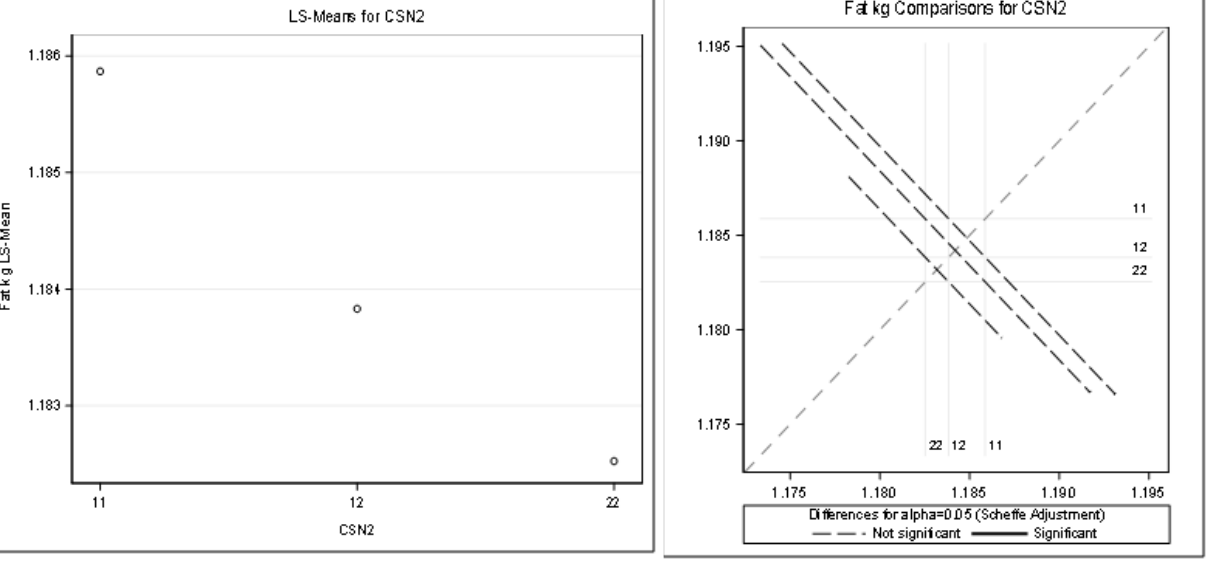
Figure 5. Least squares means and multiple comparisons for fat kg.